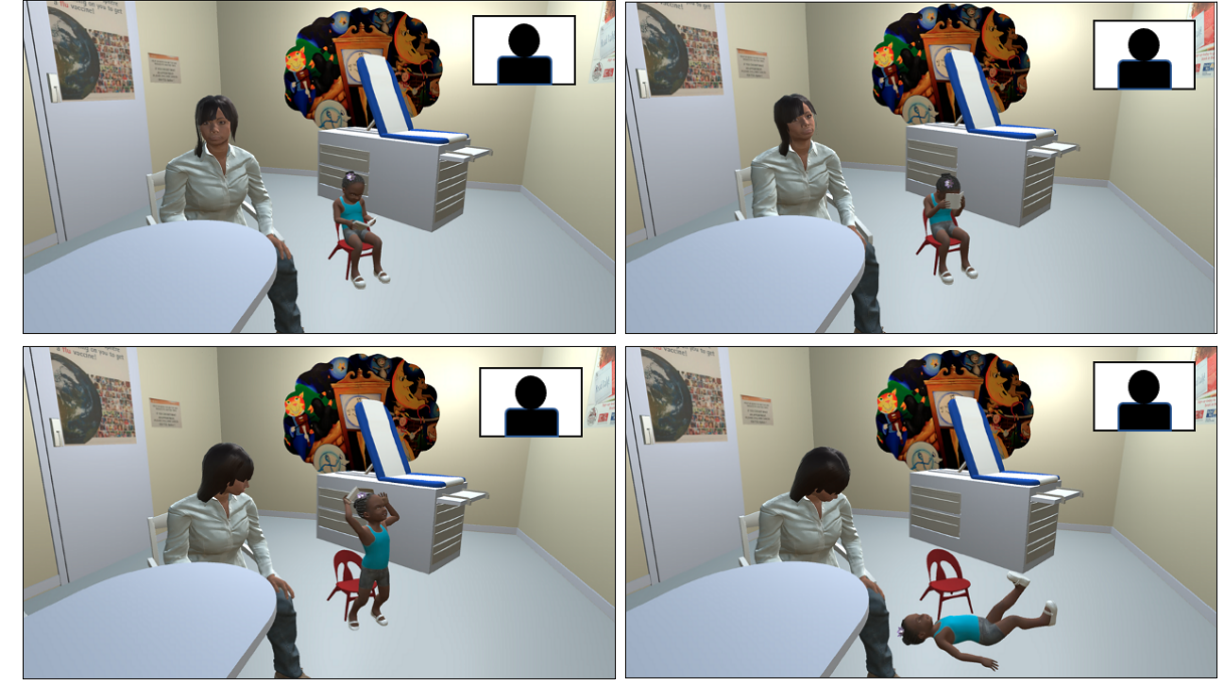
Figure 1. PREVENT included real-time interaction with an avatar family via the Zoom teleconferencing platform. Avatars were able to assume a number of different body positions including the ability for the child avatar to throw a tantrum during the clinical encounter. PREVENT: Promoting Resilience and Emotional health through Virtual Education iN